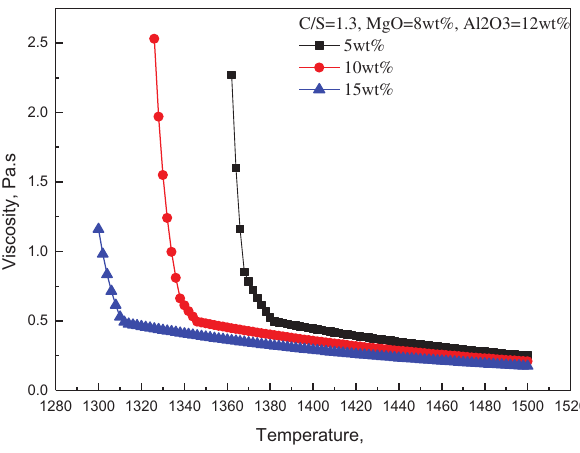
Figure 9: Effect of FeO content from 5 wt% to 15 wt% on the slag viscosity.